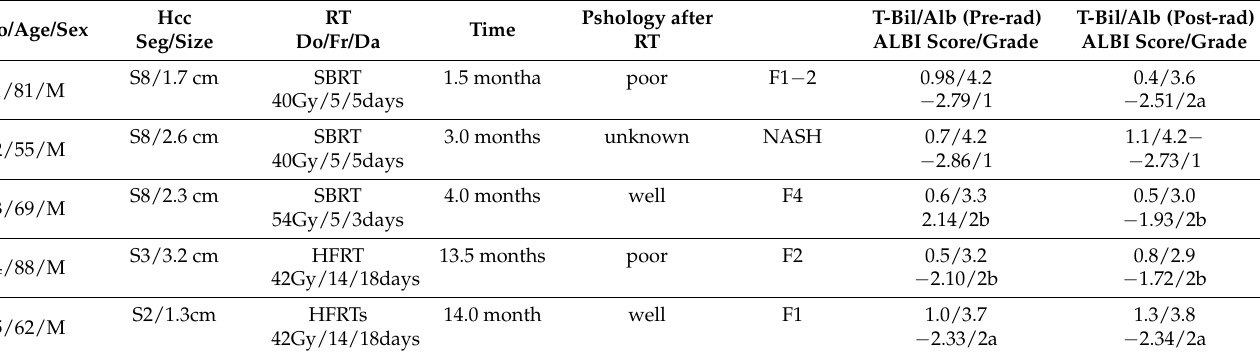
Table 1. Total bilirubin, Albumin and ALBI score: before and after radiation